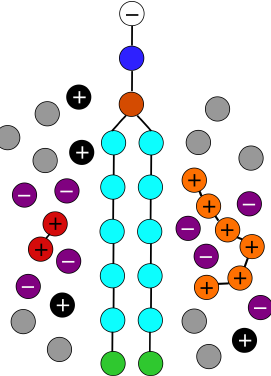
Figure 1. Negatively charged phospholipid head (Hq), white; electroneutral phospholipid head (H), blue; glycerol (G), dark orange; hydrophobic tail (C), cyan; end-bead of the tail (E), green; β -peptide (P), orange; monovalent cations (Na + ), black; monovalent anions (Cl − ), purple; divalent cations (Me 2 + ), red; solvent particles (S),